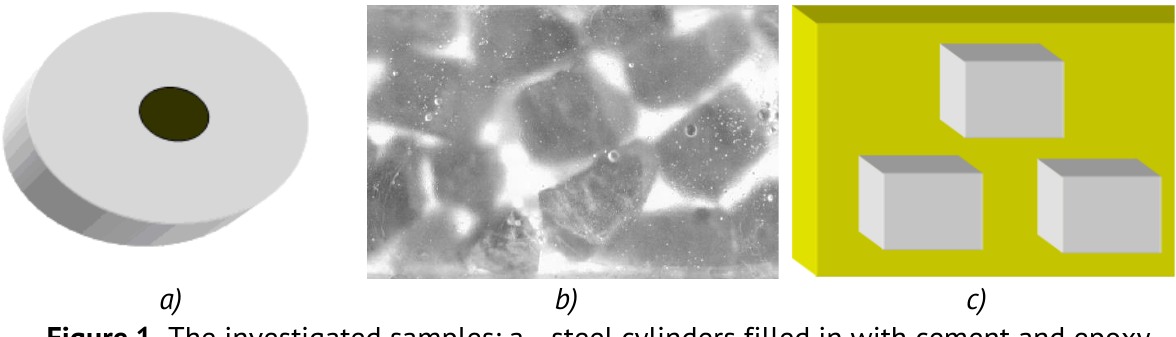
Figure 1. The investigated samples: a - steel cylinders filled in with cement and epoxy resin; b - clay filled with epoxy resin; c - epoxy poured dices of the eraser.